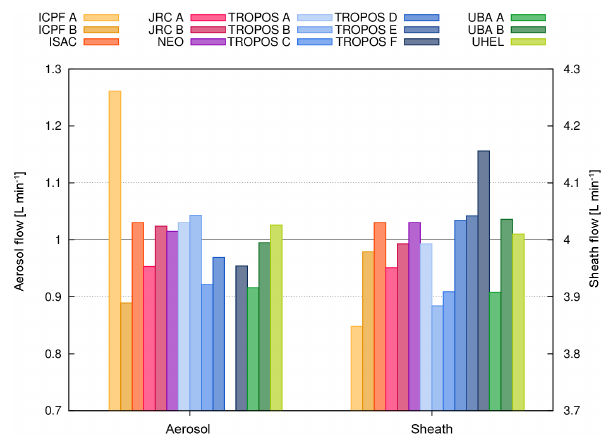
Figure 2. Measured aerosol and sheath flow rates of the initial state.